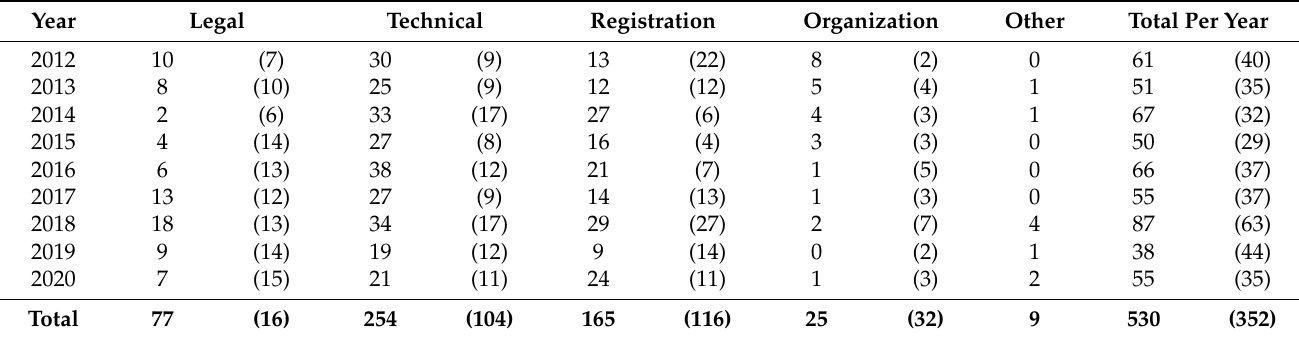
Table 1. Distribution of publications 2012-2020. () = secondary